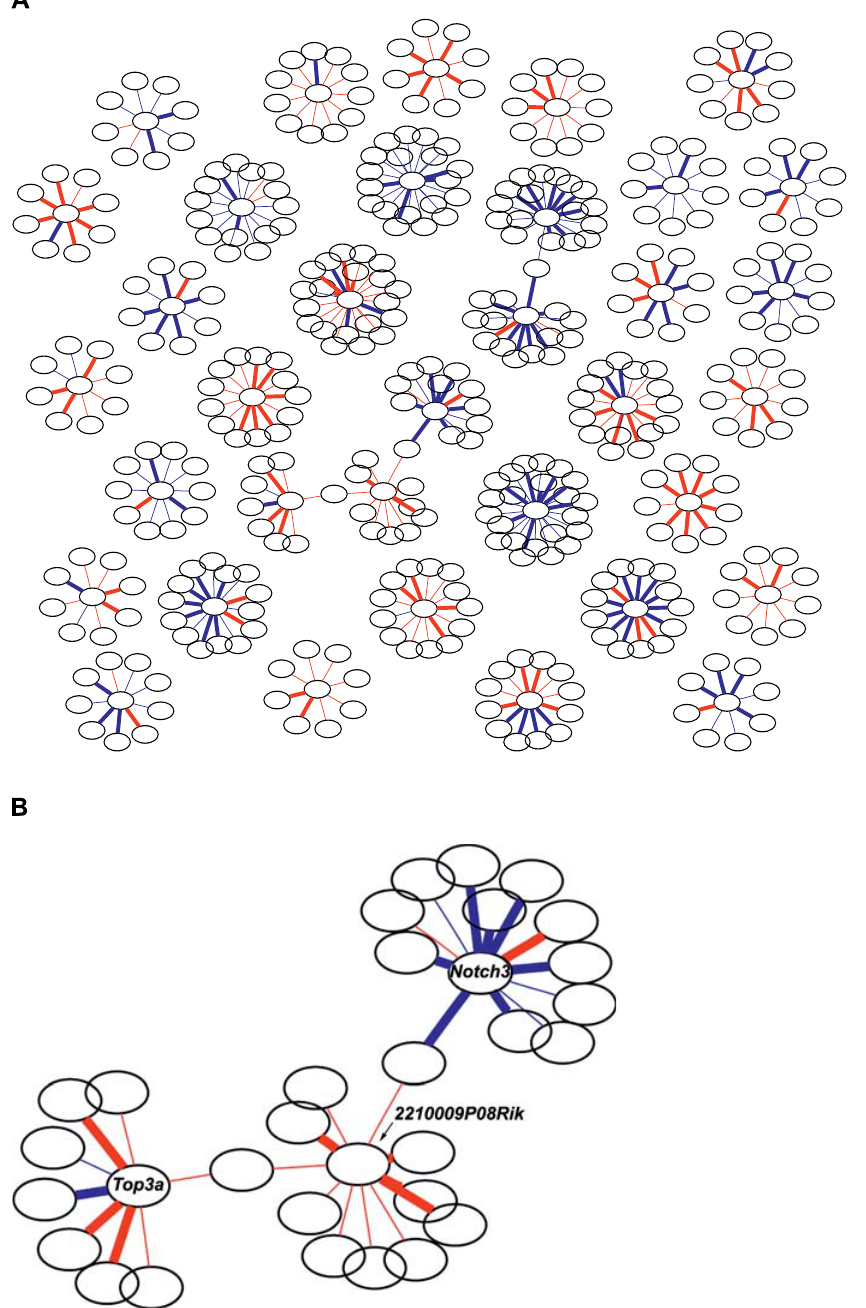
Figure 7. Differential Correlation Identifies Edges Impacted by IR The graph was filtered to identify edges that exceeded r ¼j 0.875 j in one condition but were less than j 0.25 j in the other. Vertices with . 8 differential correlations are represented in (A). Red indicates edges that are present only in IR, while blue edges are only found in control. Dark edges for each color represent the subset of edges that are differentially correlated and of opposite direction ( þ vs. (cid:1) ) in the two conditions, while bright edges are of the same direction. The portion of the graph containing three connected sub-graphs centered around Top3a , Notch3, and an unannotated gene is shown in (B). DOI: gene. For example, Figure 7B illustrates the differential edges in cell cycle checkpoint control after exposure to IR [45,46]. linked to topoisomerase III alpha (Top3a) . Unlike other Although there are relatively few negative edges in the graph, members of the topoisomerase family, Top3a has poor DNA all of the differential edges connected with Top3a are helicase activity and instead appears to interact with RecQ negative, reflecting a set of inverse relationships appearing helicases to maintain genomic stability [44]. Top3a associates only in mice from the IR group. The network of genes around with Bloom protein, a RecQ family member that participates Top3a is connected to two other structures in the graph